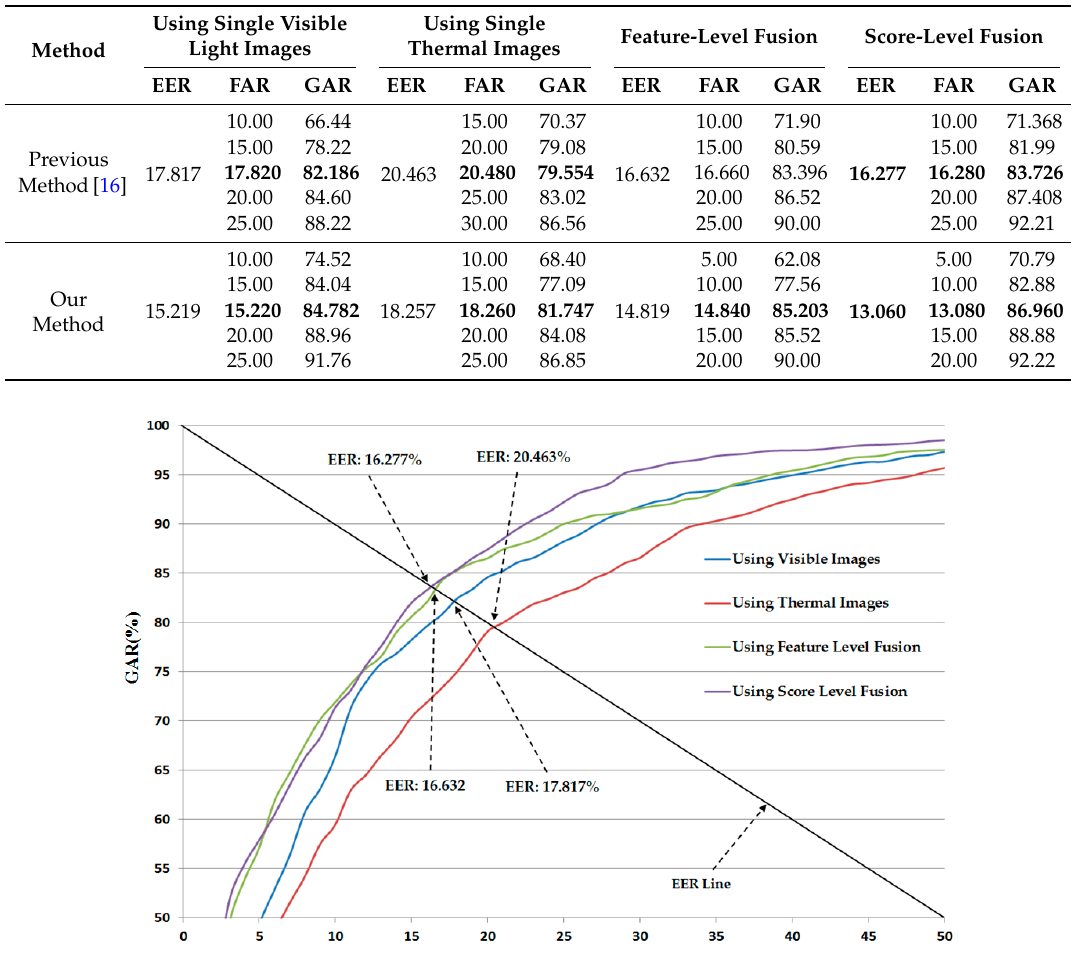
Table 10. Summary of recognition accuracy using our proposed method and the previous method (unit: %).